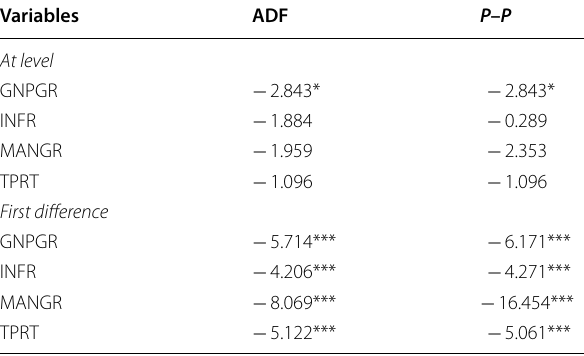
Table 3 Result of unit root